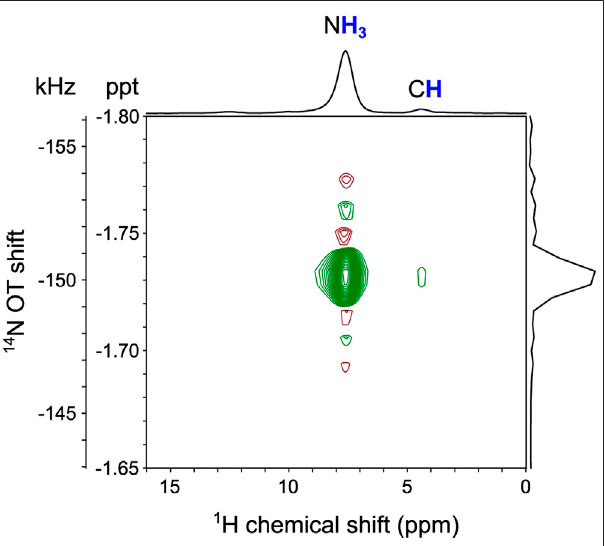
FIGURE 5 | The 2D 1 H-{ 14 N OT} D -HMQC experiment of Tyr at the magnetic fi eld ( B 0 ) of 14.1 T and ] R of 62.5 kHz. The experiment was performed at the second 14 N OT SSB ( n (cid:1) -2) for the highest S/N. Further details are given in the Experiments